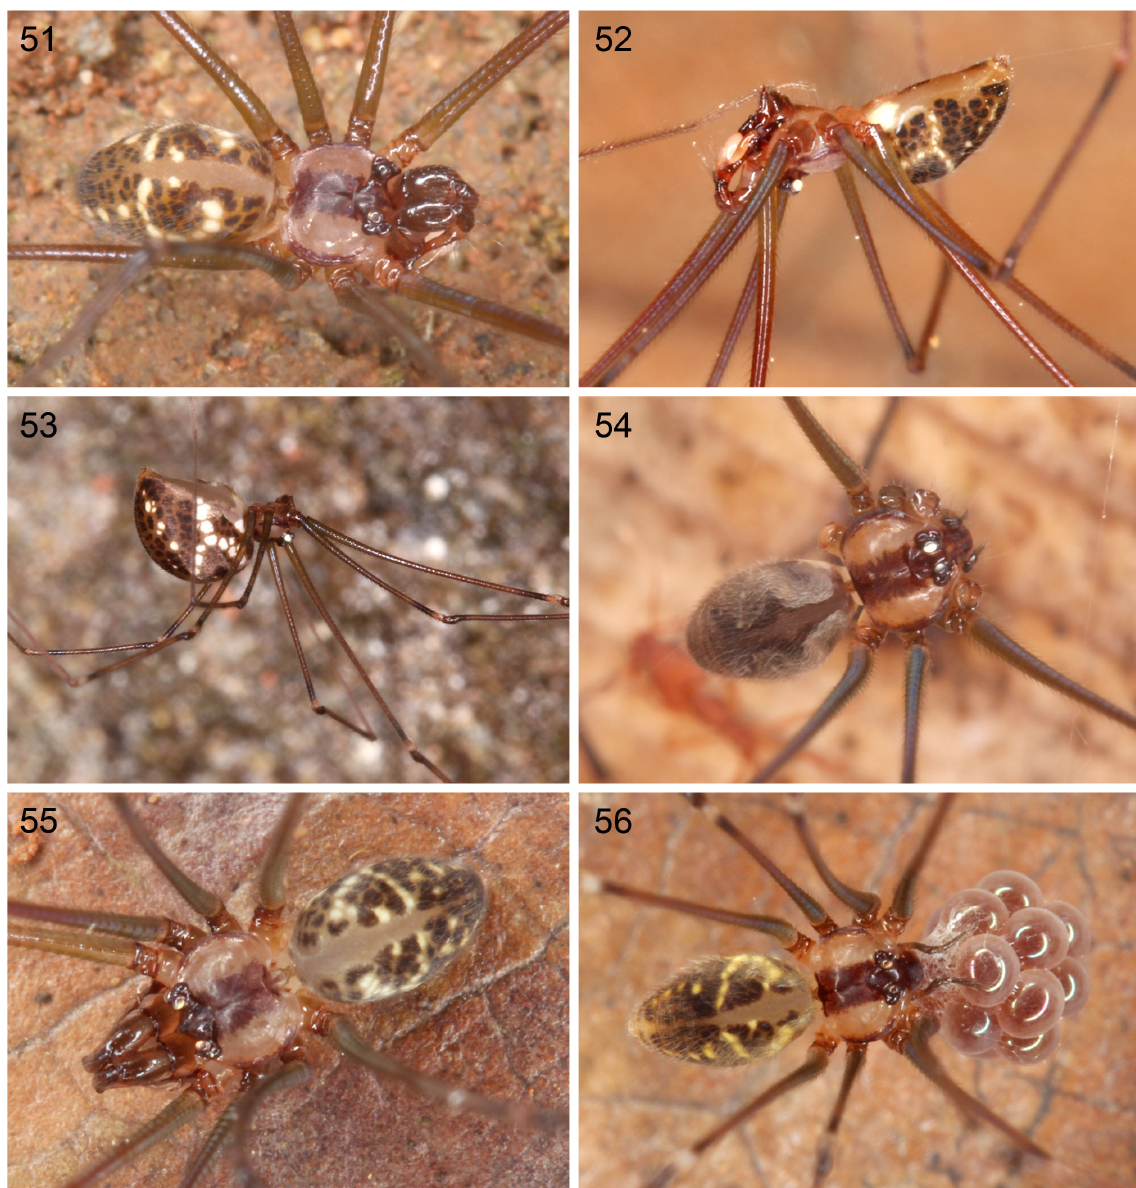
Figs 51–56. Live specimens. Aetana kiukoki group. 51–53 . A. kiukoki Huber, sp. nov., ♂ from